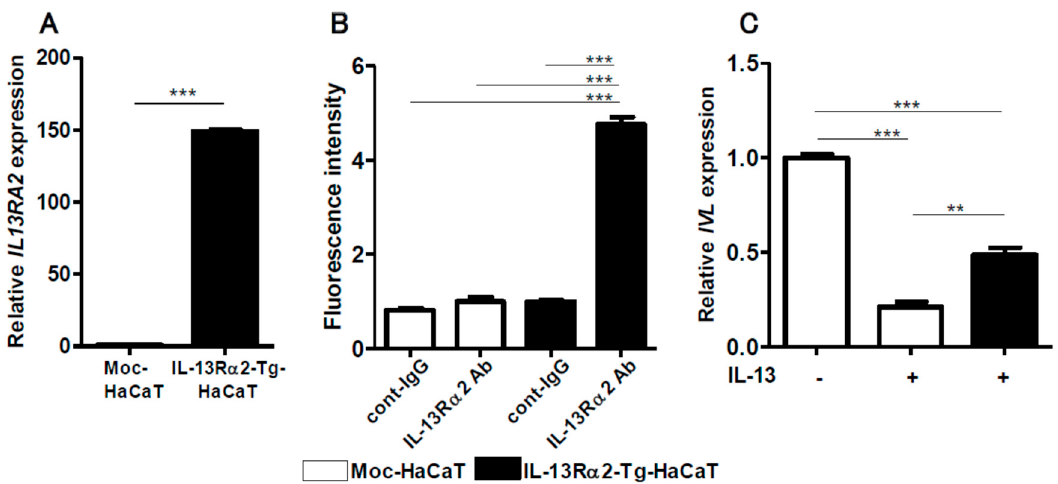
Figure 8. IL13RA2 expression was upregulated in the IL-13R α 2-Tg-HaCaT cells more than in control Moc-HaCaT cells ( A ). Upregulated IL-13R α 2 protein expression was observed in the IL-13R α 2-Tg-HaCaT cells, compared to that in Moc-HaCaT cells ( B ). IL-13-induced IVL downregulation was partially restored in IL-13R α 2-Tg-HaCaT cells ( C ). ** p < 0.01, *** p < 0.001.